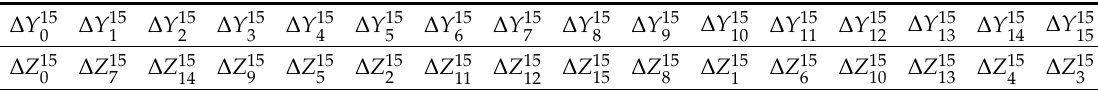
Table 2. The inverse di ff erential of Midori.